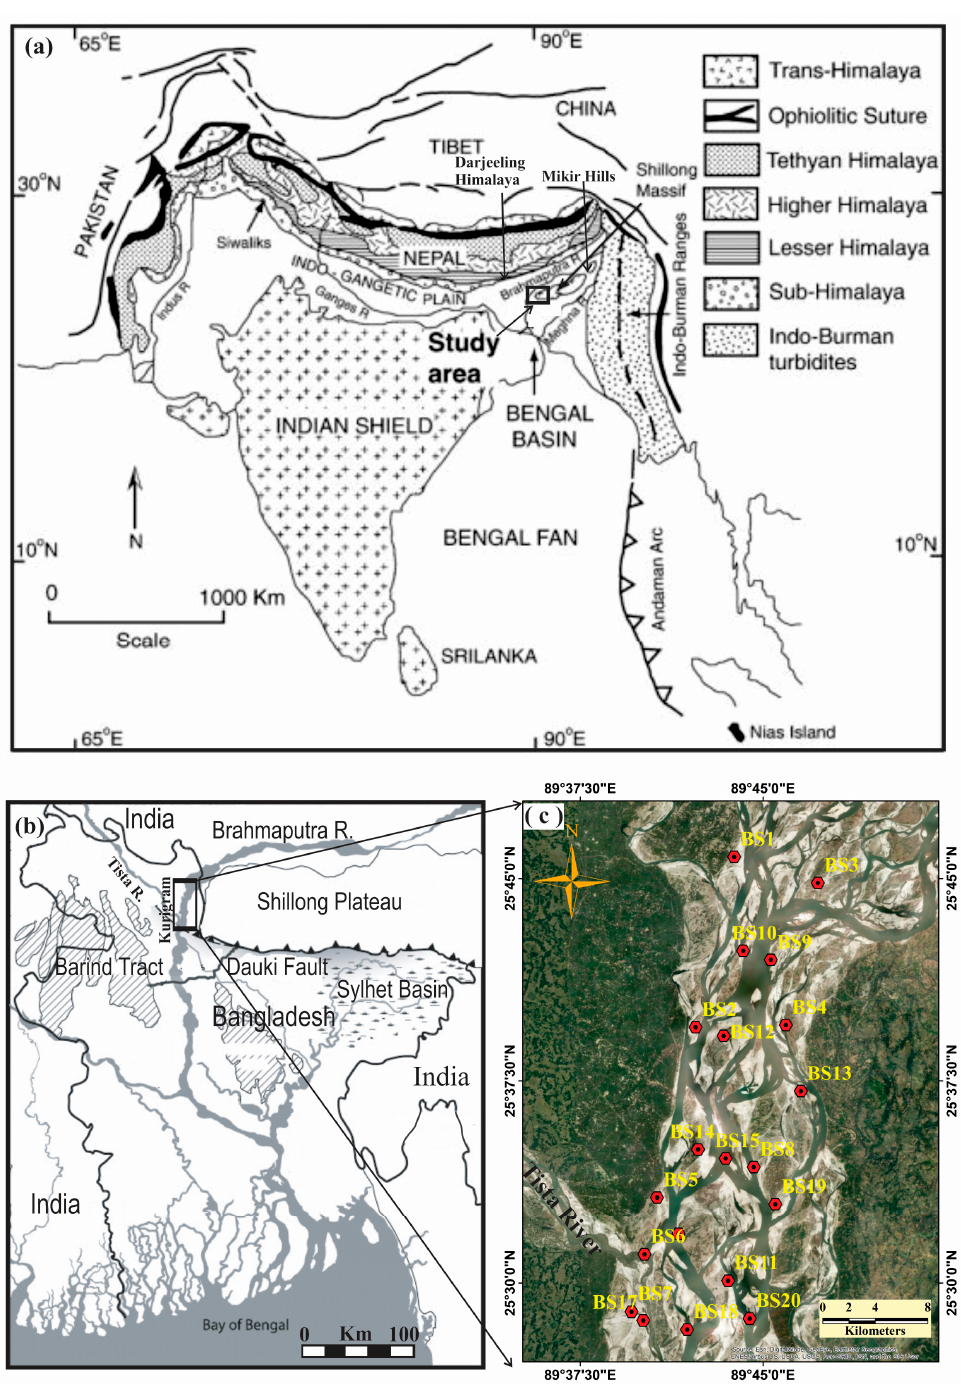
Figure 1. Regional geology maps ( a , b ) and location map of the study area ( c ) within the northern part of the Bengal Basin catchment area (modified after Goscombe et al. [18]; Heroy et al. [10]; Valdiya [19]; Clark and Bilham [20]).